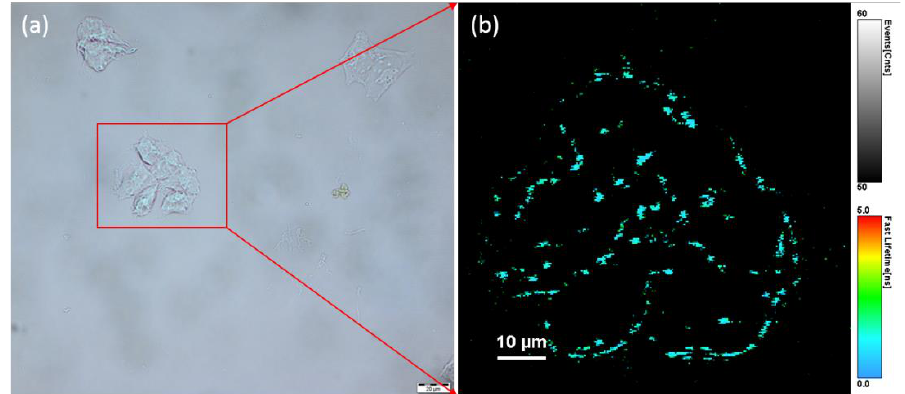
Figure 5. Microscopy imaging of A 2780 cells: ( a ) Bright-field image (63x iris oil immersion objective). ( b ) TPE-FLIM image after incubation for 24 h with dye 13 (time-resolved confocal fluorescence microscope system coupled to a Ti:Sa tunable femtosecond laser at 800 nm, using up to 25 mW of the laser beam’s power).